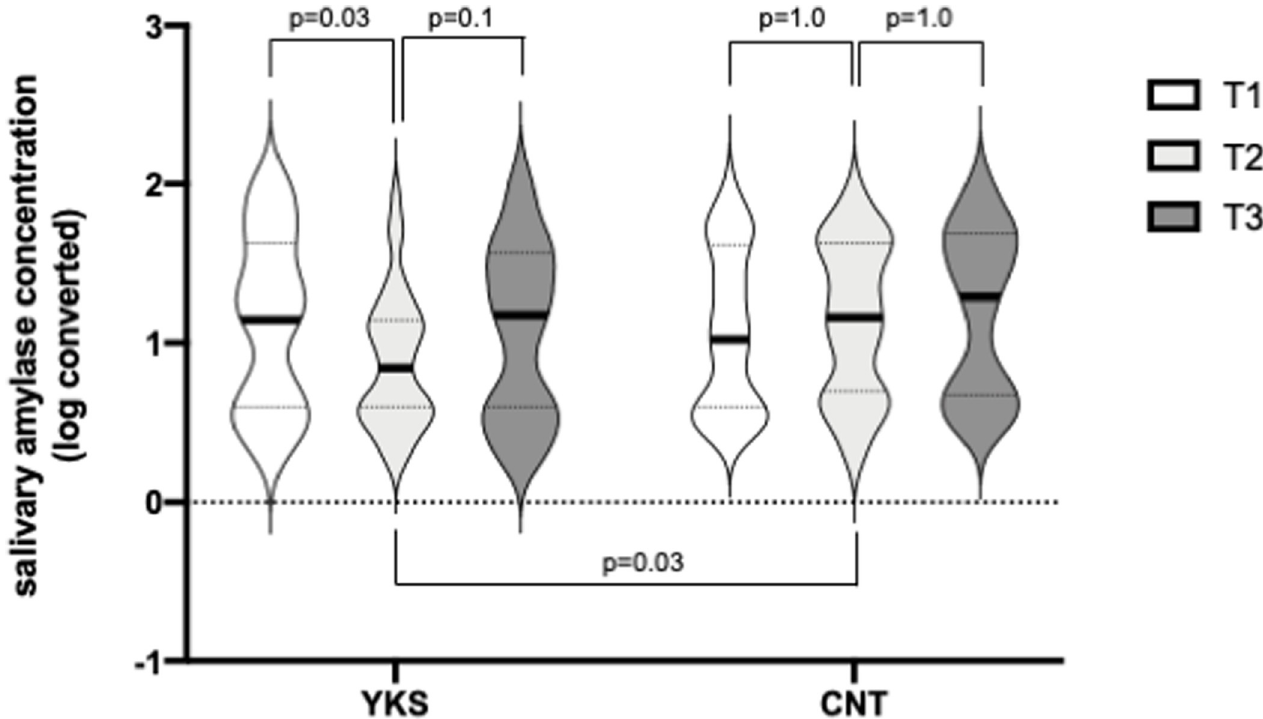
Fig 2. Salivary- α -amylase activity. Comparison of salivary- α -amylase activity in the Yokukansan (YKS) (a) and control (CNT) (b) groups by violin plots. Plot width is scaled to data distribution. Horizontal bars represent medians, and dashed lines represent 25 th and 75 th percentiles. The vertical axis represents logarithmically converted values. Data were analyzed by a two-way repeated-measures ANOVA and pre-specified follow-up tests of primary outcomes. Using a modified sequentially rejective Bonferroni test, a primary outcome with a p-value < 0.05 was considered statistically significant.